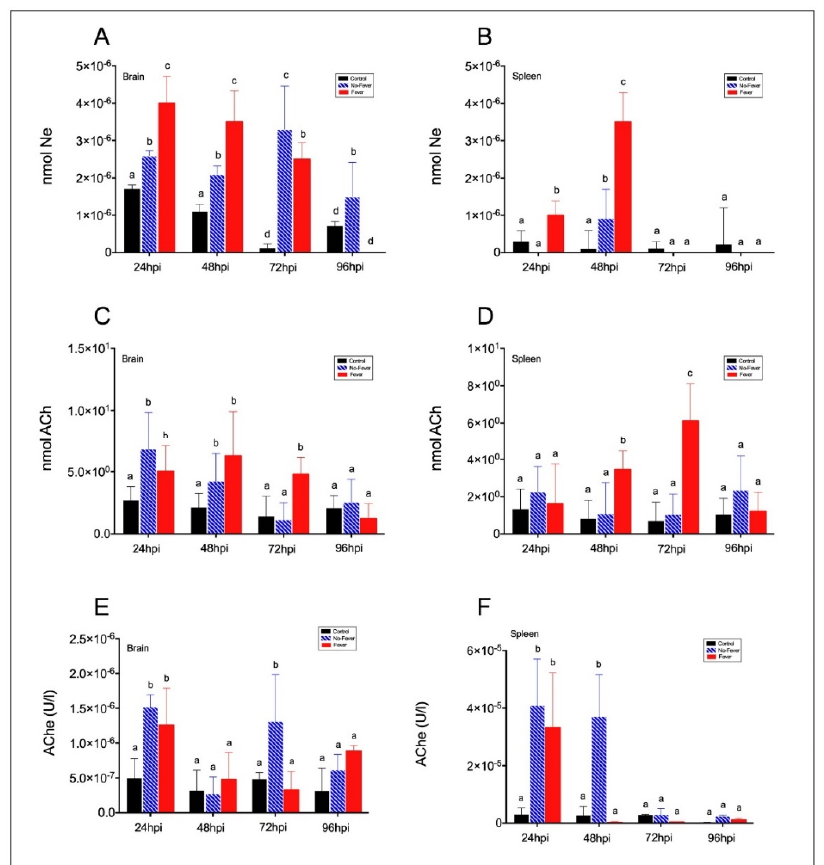
Figure 5. Behavioural fever increases norepinephrine and acetylcholine levels in the brain and spleen of viral-infected fish. ( A , B ) Norepinephrine (Ne) was measured by HPLC-FL system in brain and spleen homogenates. ( A ) In the brain, Ne levels were significantly reduced in no-fever as compared with fever fish. Different letters denote significant differences (mean ± SD, two-way ANOVA followed by Tukey’s post hoc test, p < 0.001). ( B ) In the spleen, Ne content was altered in the febrile state as compared with no-fever individuals, thus revealing a thermo coupled effect of virus infection in Ne levels in the target organ (two-way ANOVA followed by Tukey’s post hoc test, p < 0.0001). ( C , D ) Acetylcholine (ACh) levels were measured by colorimetric ELISA in homogenates from the fish brain ( C ) and spleen ( D ) during viral challenge in fever and no-fever conditions. Results are expressed as the mean of two independent experiments (mean ± SD, two-way ANOVA followed by Tukey’s post hoc test, p < 0.05). Different letters denote significant differences. Acetylcholinesterase (AChE) activity ( µ mol L − 1 min − 1 ) in the brain ( E ) and spleen ( F ) of viral-infected individuals was significantly reduced in febrile state. Bar graphs showing differences between control uninfected (black bars), no-fever (dashed blue bars), and fever (red bars) individuals (mean ± SD, two-way ANOVA followed by Tukey’s post hoc test, p < 0.05). Different letters denote significant differences. nmol: nanomoles; U/L: units per litre. hpi: hours post-infection; SD: standard